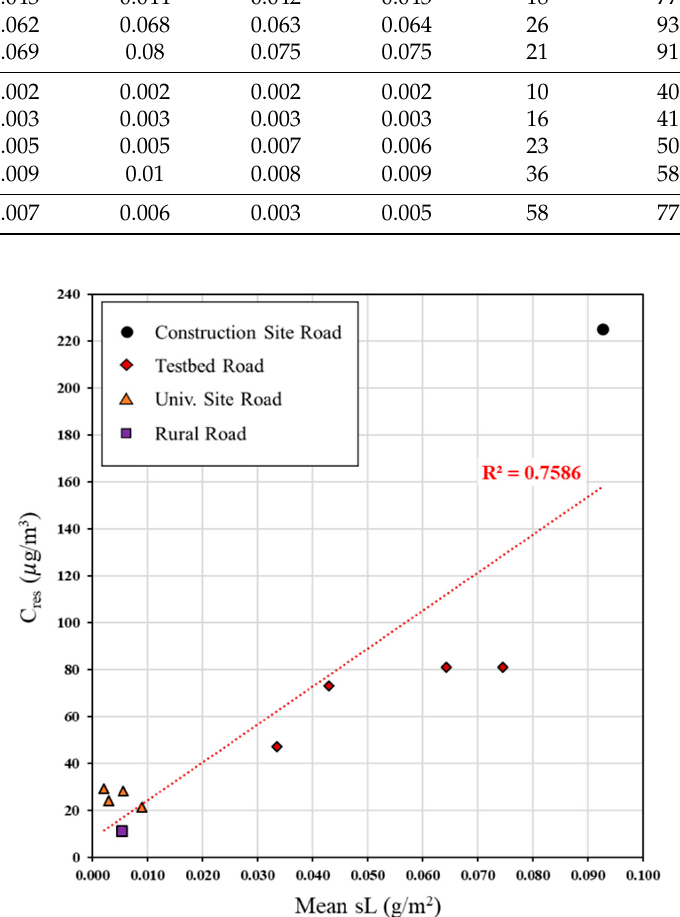
Figure 4. Trend of C res growth due to sL level in other measured sites.